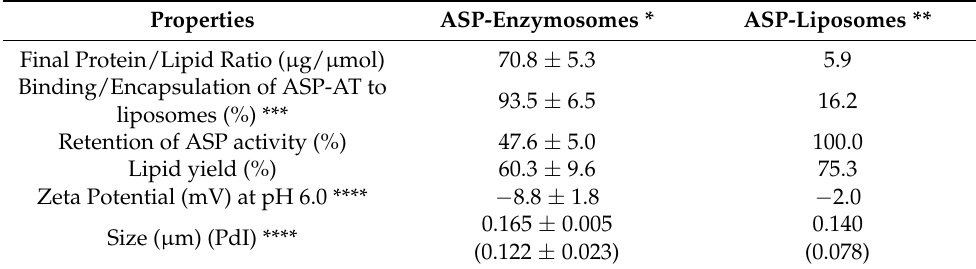
Table 1. Characterization of ASP-enzymosomes and ASP-liposomes.